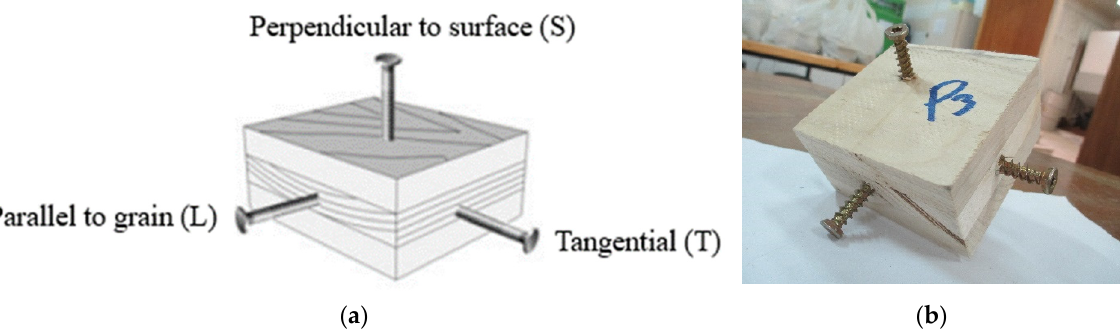
Figure 2. Loading directions ( a ) and placements of fasteners ( b ) in the CLT samples for the withdrawal tests. Smaller blocks with a dimension of 75 mm × 75 mm × 48 mm were cut from the CLT panels, and a fastener was inserted in the three directions as shown in Figure 2a: parallel to the grain in the middle layer (L), the tangential direction of the middle layer (T), and perpendicular to the surface of the CLT panel (S). Fasteners were inserted at a 32 mm penetration depth into the CLT samples, as depicted in Figure 2b. The fasteners were placed to eliminate any gaps and to meet the requirements of boundary conditions, and end and edge distances stipulated in previous studies [14,51]. In other words, it means that the distance between the screws in different directions was such that they did not affect each